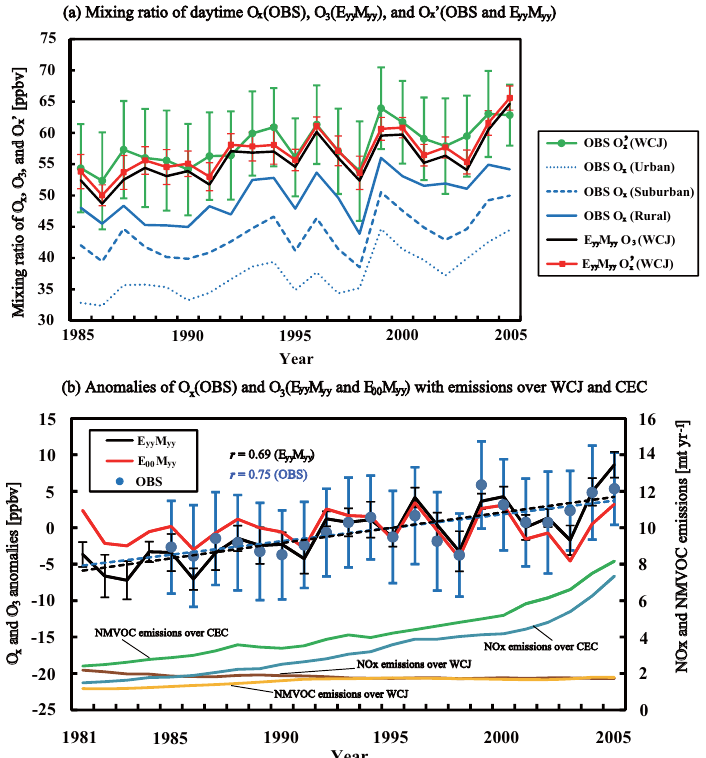
Fig. 5. (a) Time series of the daytime springtime surface mixing ratios of observed O x and simulated O 3 for the E yy M yy scenario during 1985–2005. Simulated O 3 mixing ratios are averaged over WCJ (black line), and observed O x values are the average of measurements over urban (blue dotted line), suburban (blue dashed line), and rural (blue solid line) areas. The time series of daytime springtime surface O x ’ over WCJ calculated with observed (green line) and simulated (red line) results are also plotted. (b) Time series of anomalies of springtime observed surface O x (blue points) and simulated BL O 3 for the E yy M yy (black line) and E 00 M yy (red line) scenarios averaged over WCJ during 1981–2005. Anomalies are defined as deviations from the values averaged over 1985–2005. The blue regression line and correlation coefficient ( r ) are for observations, and the black ones are for simulations by E yy M yy . Emissions of NO x and NMVOC over WCJ and those over CEC are also shown. Note that the whiskers denote 1 standard deviation. Standard deviation of observations was calculated from the springtime-averaged values at each station. That of simulations was based on the values of springtime mean at each grid point over